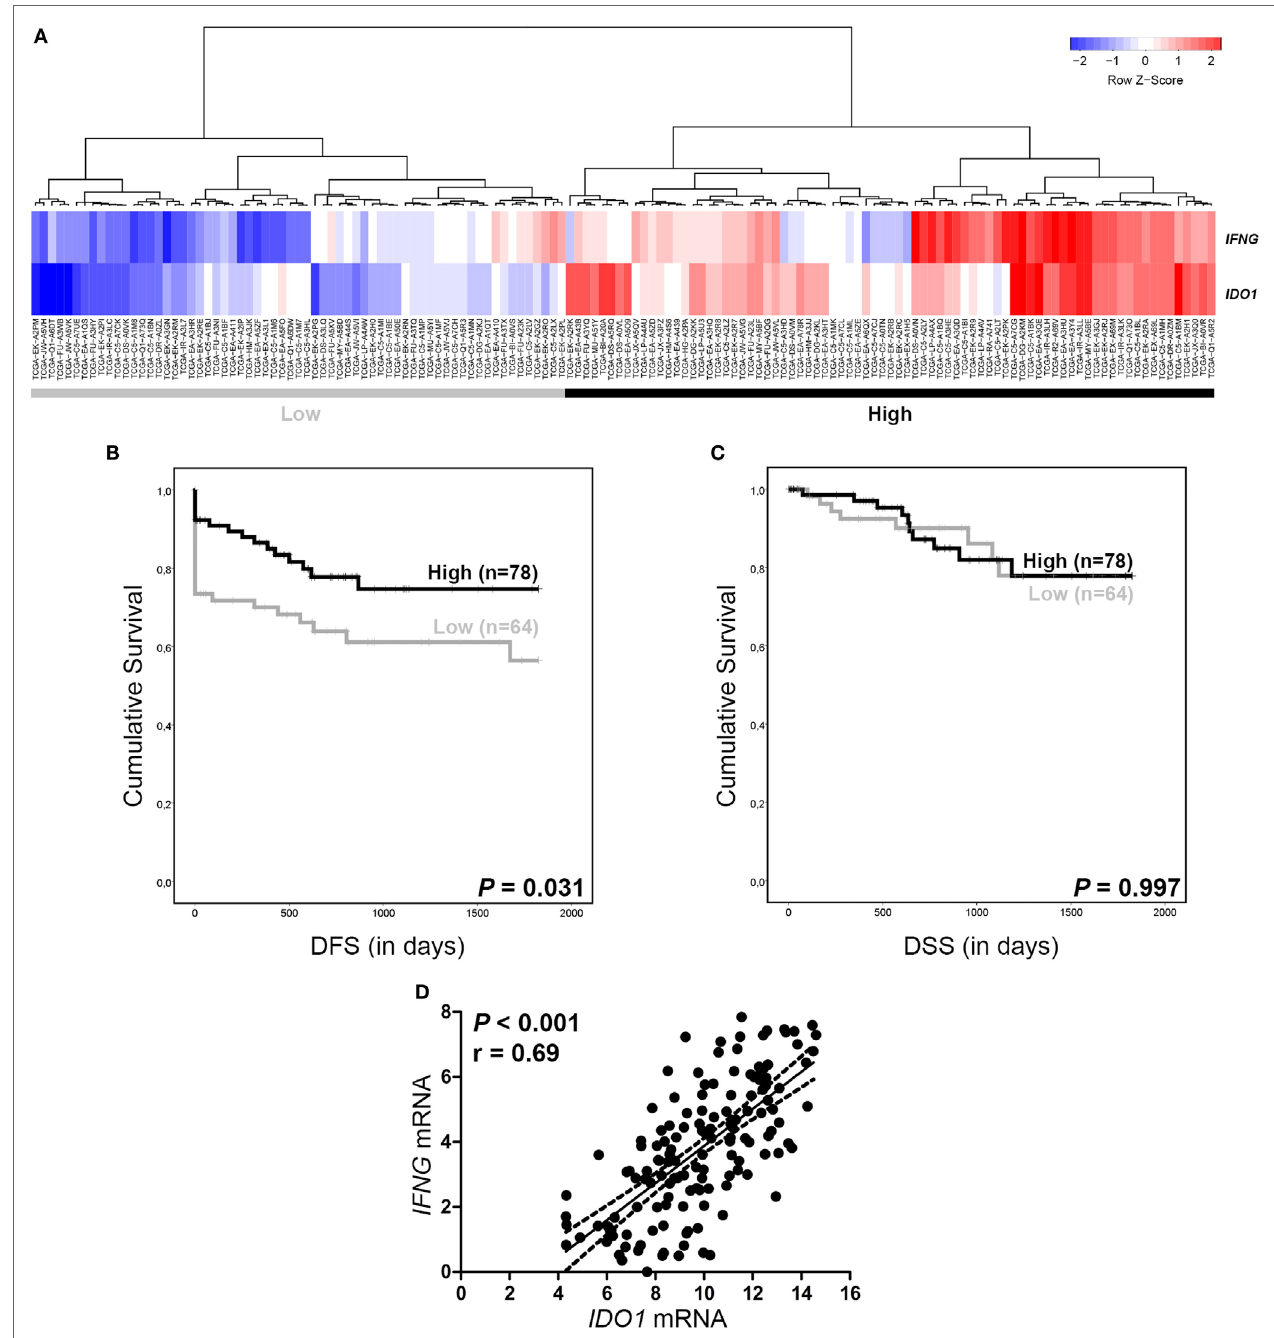
FigUre 6 | IDO1 and IFNG RNAseq data from The Cancer Genome Atlas. (a) Hierarchical clustering of IDO1 and IFNG mRNA (rows) measured on primary tumor samples from 144 cervical SCC patients (columns) reveals a “High” (for both IDO1 and IFNG ) and a “Low” (for both IDO1 and IFNG ) patient group. Kaplan–Meier 5-year survival curve shows (b) disease-free survival (DFS) and (c) disease-specific survival (DSS) for patients with both high IDO1 and IFNG (black line) and patients with both low IDO1 and IFNG (gray line), based on hierarchical cluster analysis. (D) Graph shows correlation between IDO1 and IFNG . NB: survival data was missing for two patients. P values for survival analysis were calculated using the log-rank test. P value for correlation analysis was calculated using Pearson’s